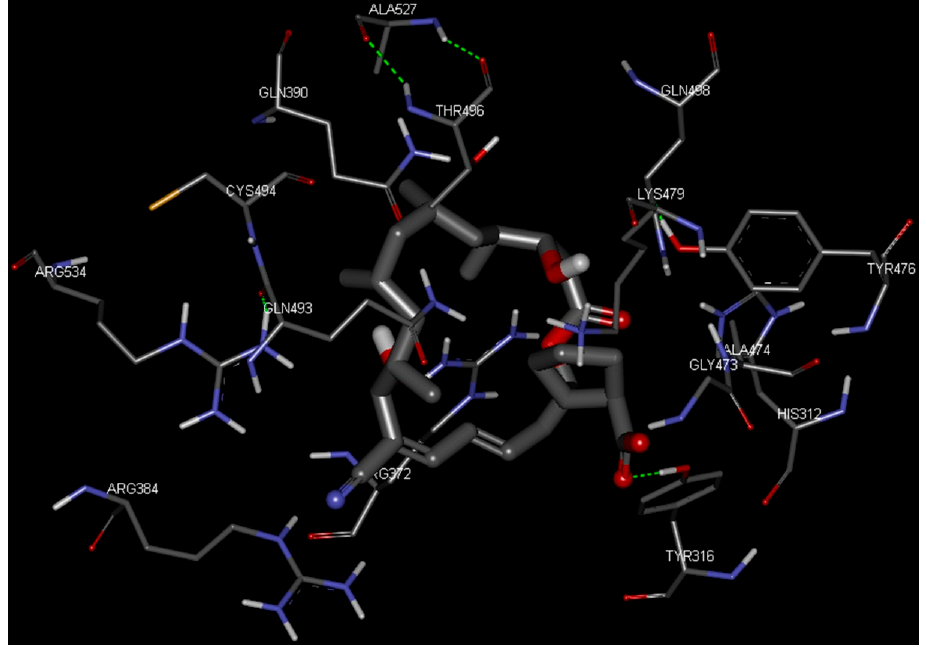
Figure 4. Predicted binding mode of borrelidin, as determined by docking of the ligands in the BaThrRS homology model.